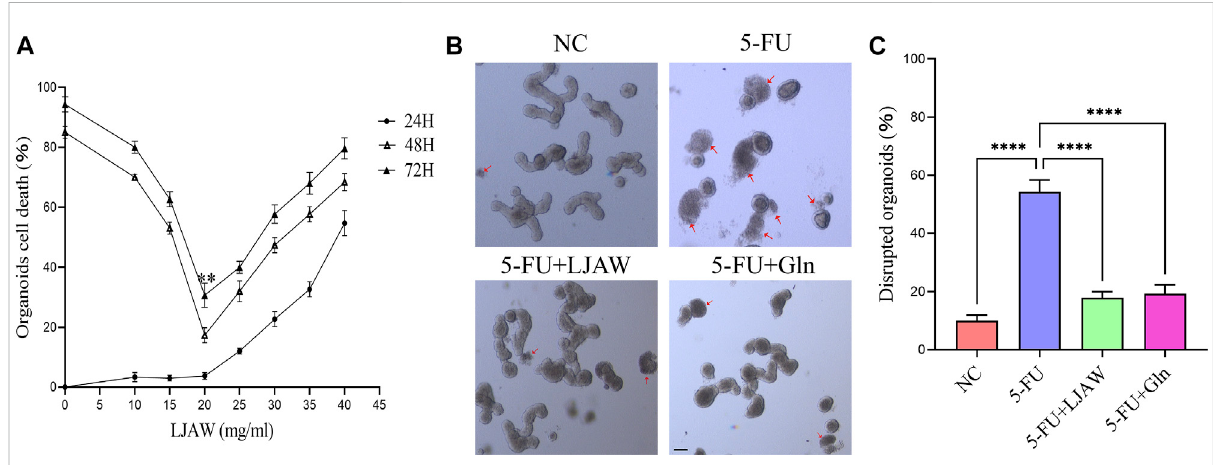
FIGURE 2 Protective effect of LJAW on 5-FU-induced intestinal organoids injury (A) Organoid cell death under different concentrations of LJAW after different intervention times detected by MTT, 24H: LJAW intervention for 24 h before adding 5-FU, 48H: LJAW intervention for 48 h, 5-FU intervention for 24 h, 72H: LJAW intervention for 72 h, 5-FU intervention for 48 h (B) and (C) Effect of LJAW on morphological of organoids. Count thetotalorganoidsandthenumberofdisruptedorganoidsperwell(thedisruptedorganoidsaremarkedbyredarrows).Scalebar,100 μ m.Data are expressed as means ± SD (n = 3). ** p < 0.01 compared with the 48H group. **** p < 0.0001 compared with the 5-FU